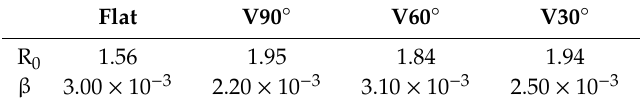
Table 2. Parameters obtained by fits to the drag force model for time delays longer than 600